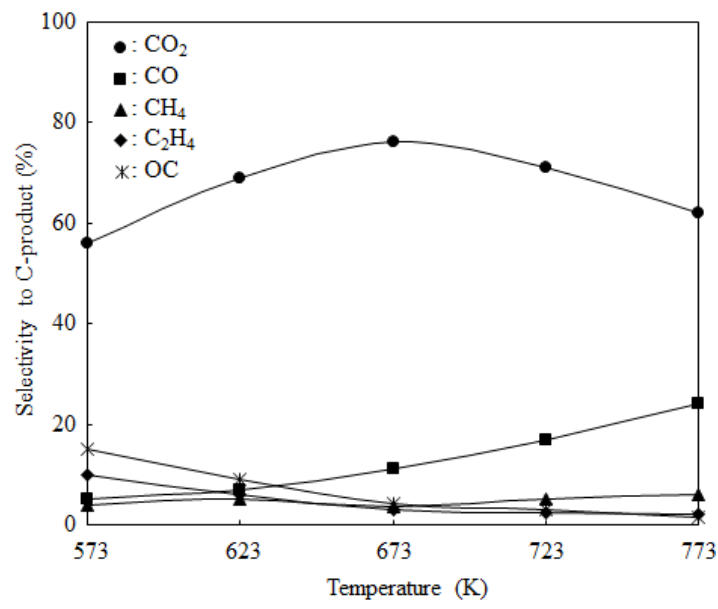
Figure 7. Effect of reaction temperature on selectivity to C-containing products over 7.7 wt. % Co/CeO 2 (hp).